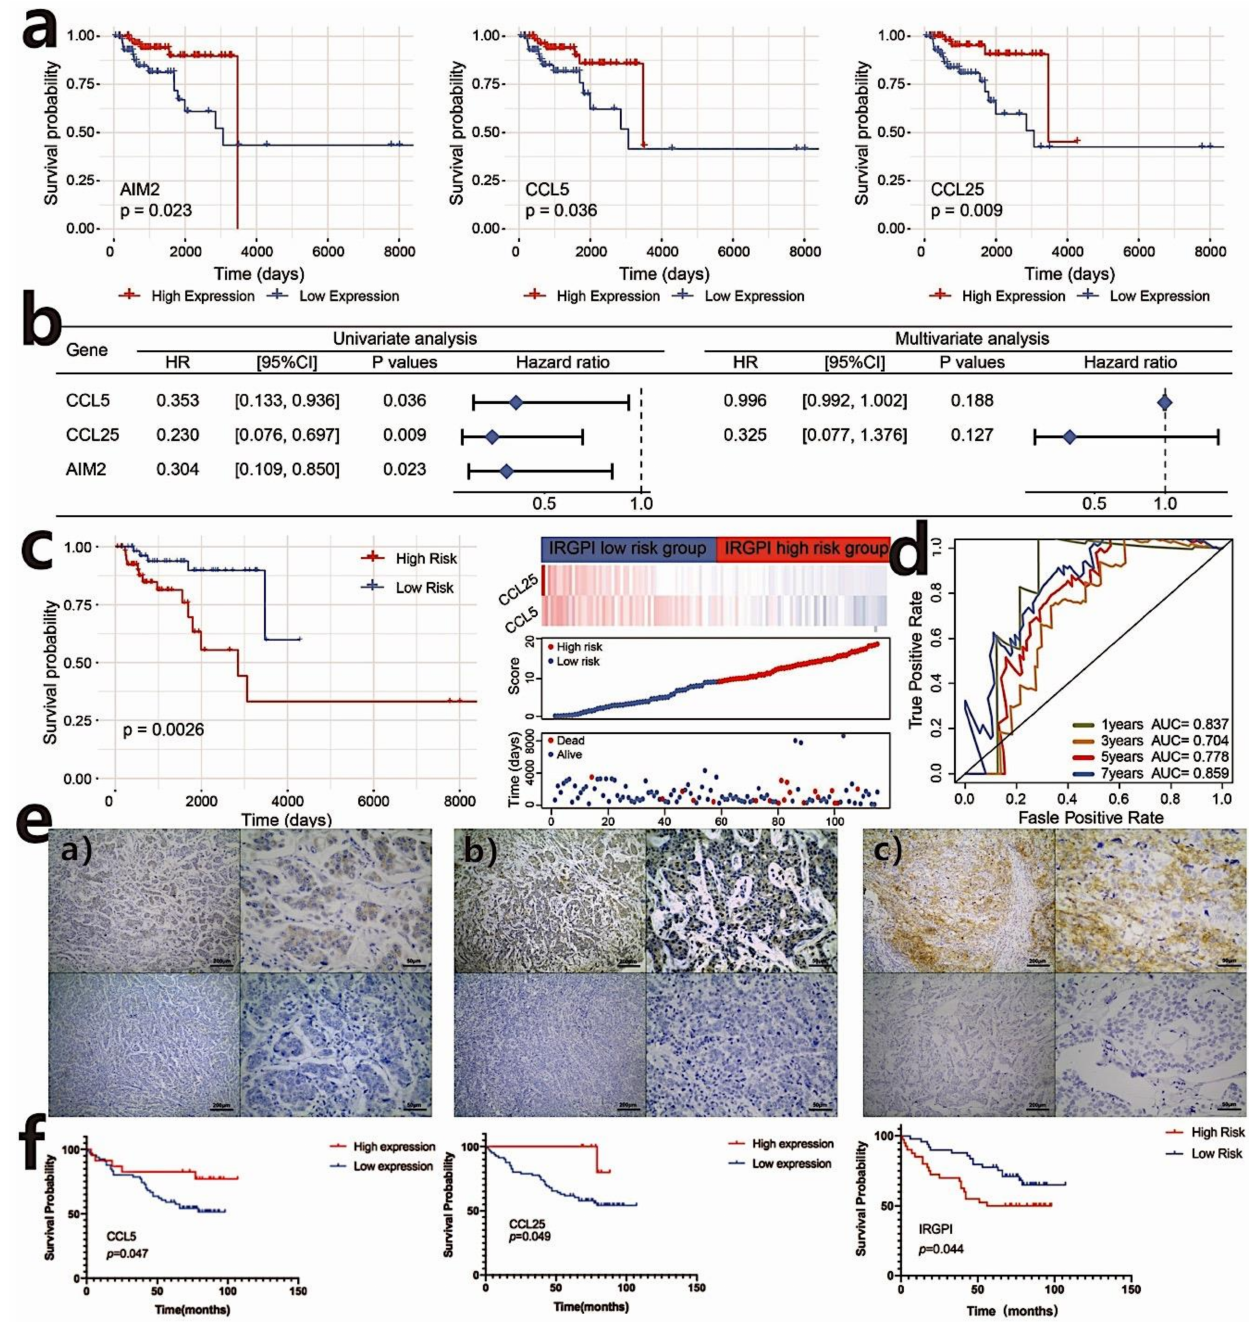
Figure 3. Construct of the immune-related gene prognostic index (IRGPI) in TNBC. ( a ) Kaplan–Meier survival analysis of AIM2, CCL5, and CCL25 genes that are significant in the univariate Cox analysis ( p < 0.05); ( b ) univariate and multivariate Cox regression analysis of survival-related genes; ( c ) Kaplan–Meier survival analysis of IRGPI scores using TCGA data and the relationship between the survival status and IRGPI score distribution in the TCGA TNBC cohort; ( d ) ROC curves of the prognostic models in TNBC (the TCGA cohort) at 1, 3, 5, and 7 years; ( e ) expression of CCL25, CCL5, PD-L1 in TNBC. ( a ) Representative samples with CCL25 positive (above) and negative (below) expression; ( b ) representative samples with CCL5 positive (above) and negative (below) expression; ( c ) representative samples with PD-L1 positive (above) and negative (below) expression. Scale bars: 200 µ m for the left pictures in ( a – c ), and 50 µ m for the right pictures in ( a – c ); ( f ) Kaplan–Meier survival analysis of CCL5 and CCL25 expression and IRGPI groups using IHC scores of the patients from our hospital ( p <